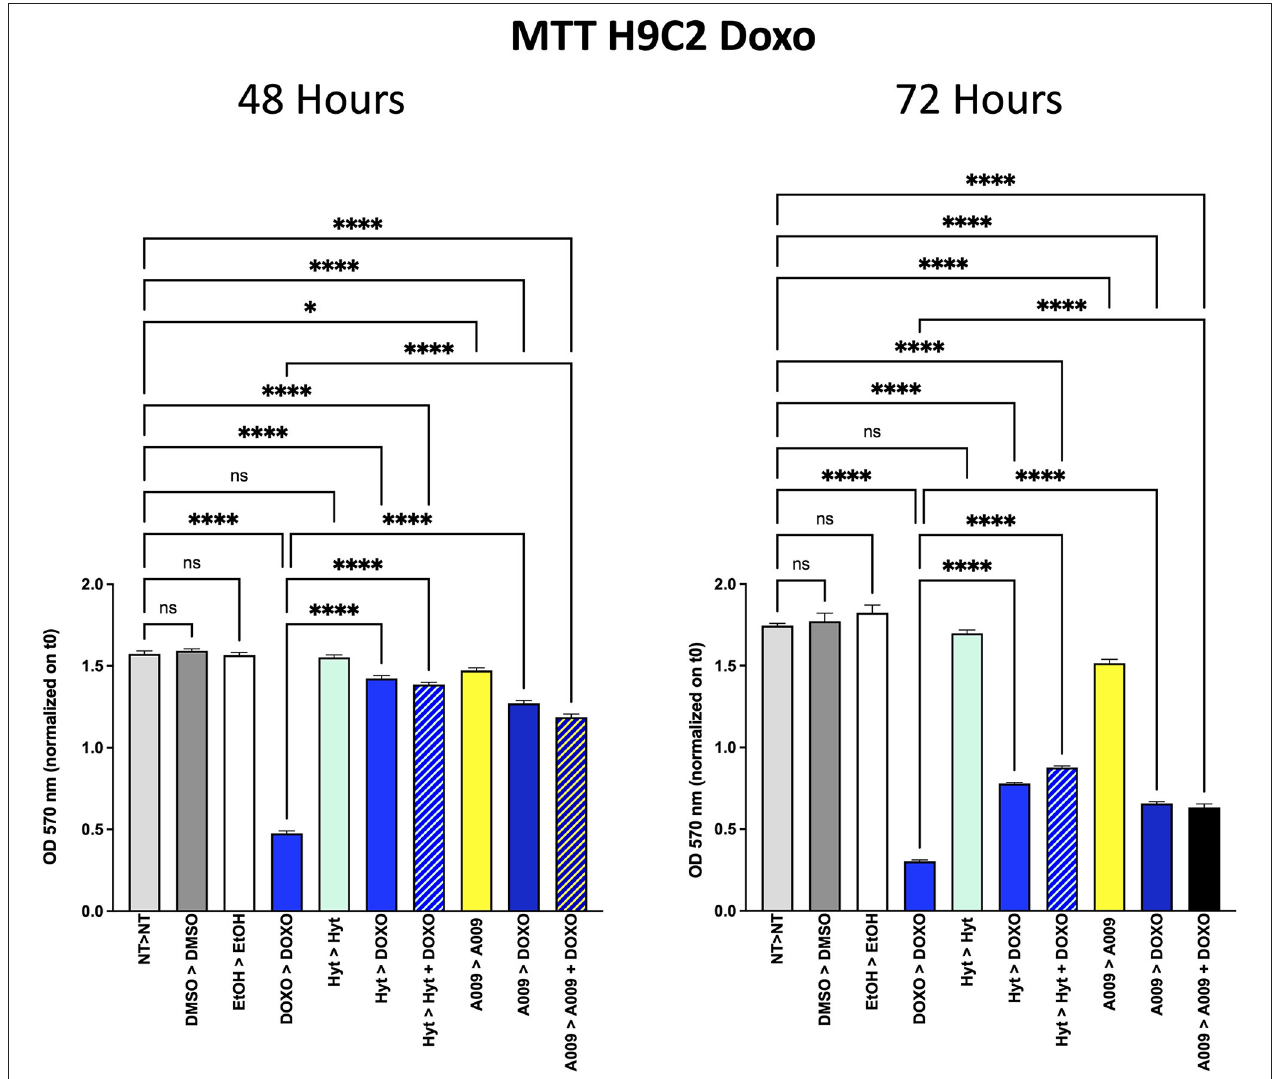
FIGURE 6 | Effects of the A009 extract in combination with doxorubicin on rat cardiomyocytes. H9C2 cells were pretreated with extract A009 (dilution 1:800) or Hyt (same concentration as that present in the 1:800 diluted A009 extract), for 24h. Later, the medium was replaced with and without Doxo 1 µ M alone or in combination with A009 or Hyt for 48 and 72h. Proliferation was detected by the MMT assay at the indicated time points. The experiments were performed in quadruplicate and repeated two times. Results are expressed as the mean of the absorbance normalized on the T0 SEM, one-way ANOVA, * p < 0.05 and **** p < 0.0001. A009 ± combinations with chemotherapy were less toxic toward cardiomyocytes than toward breast cancer